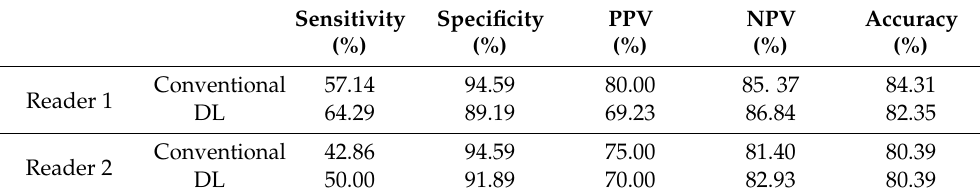
Table 6. Diagnostic accuracy of ALN metastasis *.